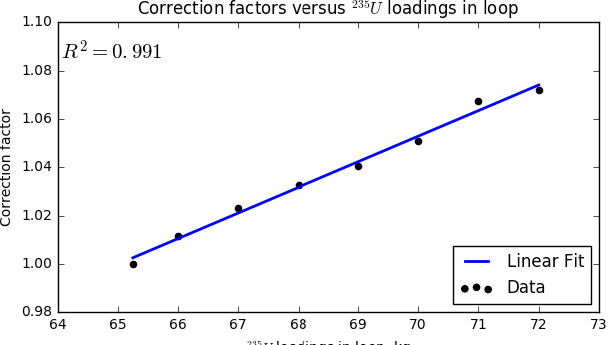
Figure 5. Correction Factor for Different 235 U Loadings in